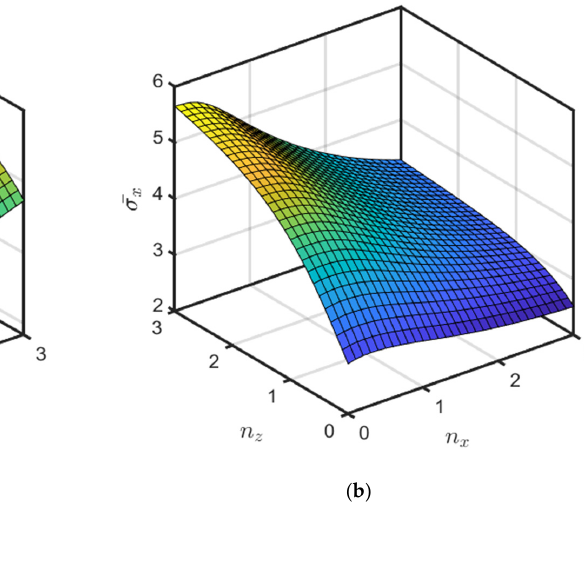
Figure 5. Neutral axis paramaters 𝑧 (cid:2868) /ℎ and 𝑐 (cid:2868) /ℎ at different 𝑛 (cid:3051) and young’s modulus of ceramic and metal, 𝐸 (cid:3030) 𝐸 (cid:3040) ⁄ = 6 at (𝑎 ℎ⁄ = 10,𝑛 (cid:3053) = 1) ( a ) for 𝑧 (cid:2868) /ℎ and ( b ) for 𝑐 (cid:2868) /ℎ . Influences of the gradation 𝑛 (cid:3051) and 𝑛 (cid:3053) for a different 𝑎/ℎ − 𝑟𝑎𝑡𝑖𝑜 on 𝑤(cid:3365),𝜎(cid:3364) (cid:3051) ,𝜏̅ (cid:3051)(cid:3052) ,𝜏̅ (cid:3051)(cid:3053) for immovable BDFG Al/Al (cid:2870) O (cid:2871) square plate at specified points a uniform distributed load are presented in Table 7. The quantitative analysis of Table 8 is portrayed in the 3D plots shown in Figure 6. As shown, the highlights deflection and shear stresses are obtained for higher gradation indices; however, the higher normal stress is obtained at 𝑛 (cid:3053) = 3 and 𝑛 (cid:3051) = 0 , as seen in Figure 6.